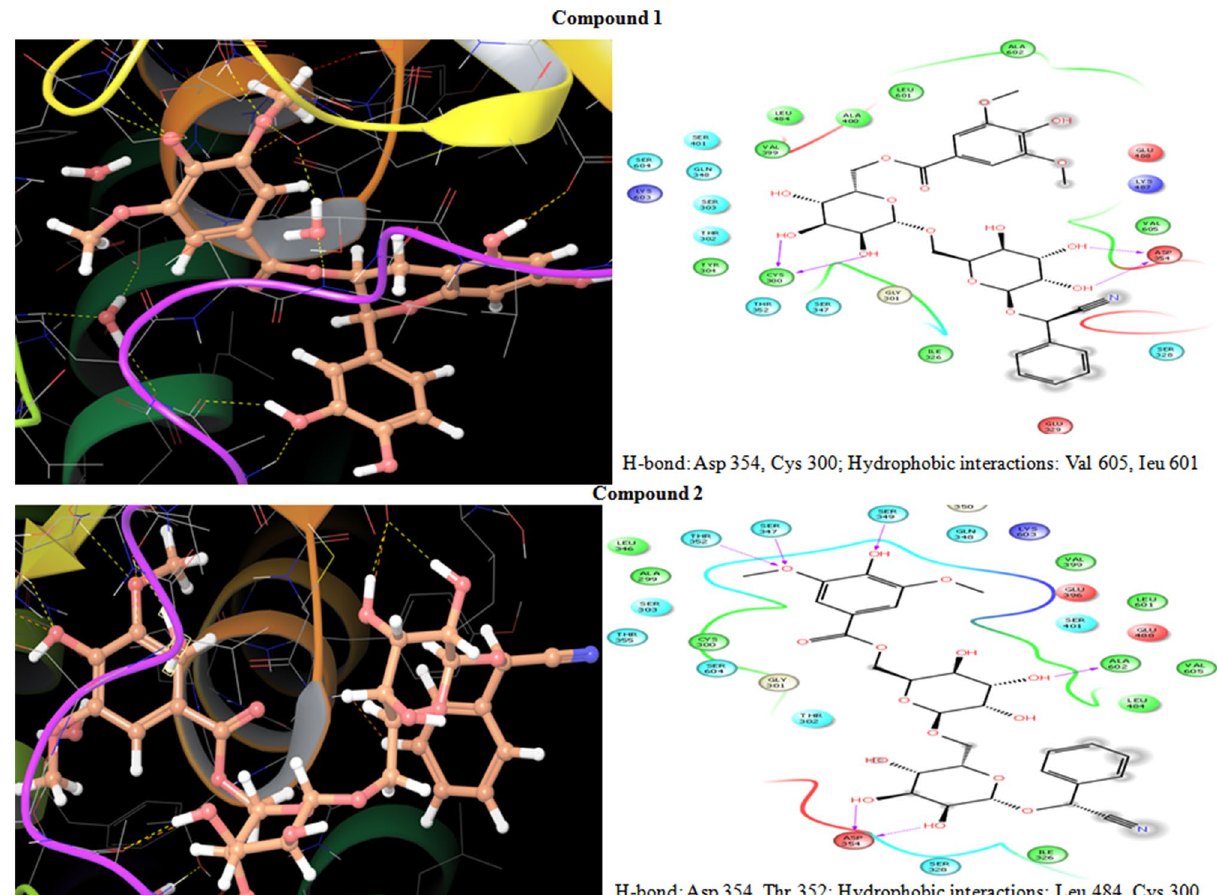
Figure 2. Interaction patterns of ligands within the G-6-P synthase